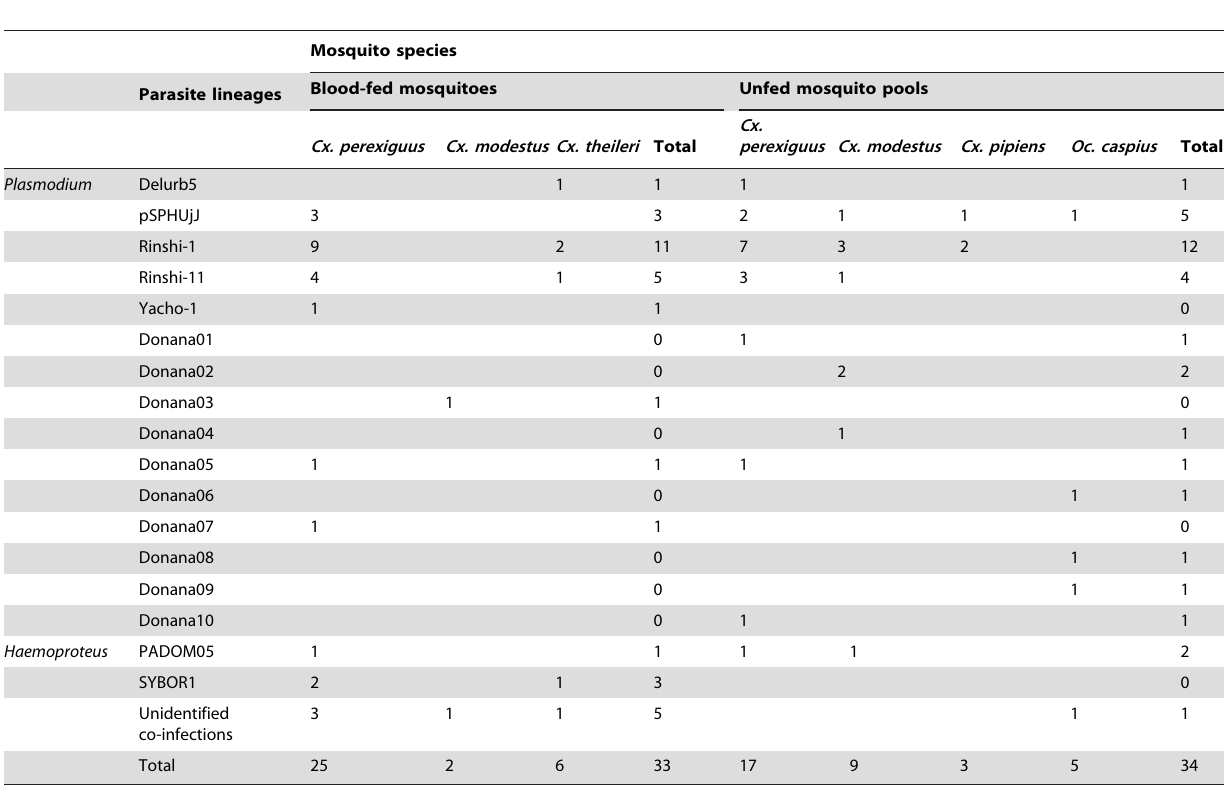
Table 1. Avian Plasmodium and Haemoproteus lineages detected in female blood-fed individuals and unfed mosquito